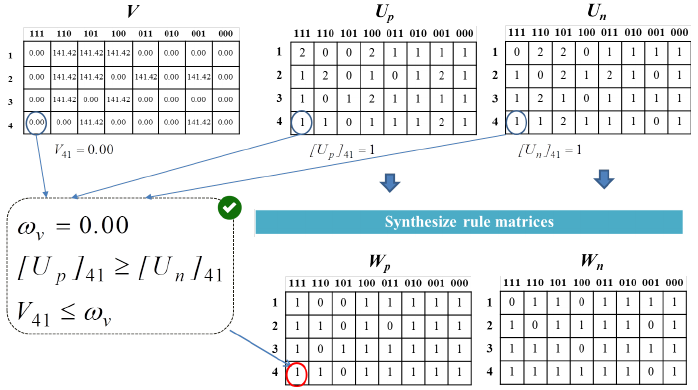
Figure 6. Synthesis rule